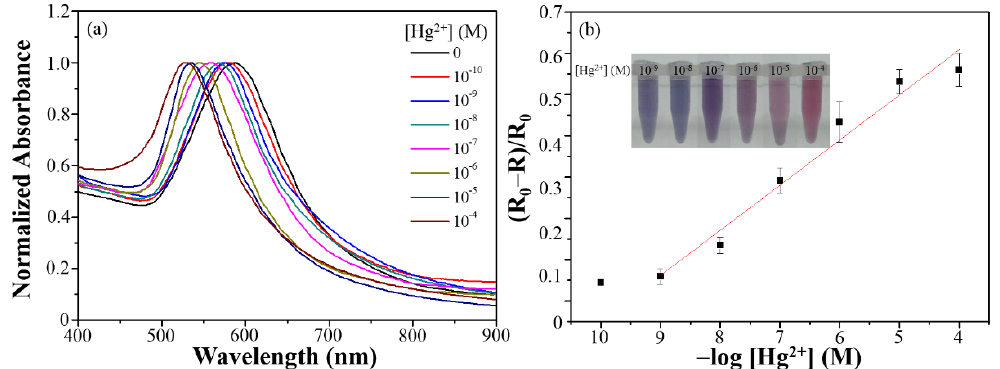
Figure 9. ( a ) UV–Vis absorbance spectra and ( b ) linear responses of the catalytic effect plotted against the Hg(II) concentration. Inset: photographs of the H-AuNS probe in the presence of HCl/Au(III)/H 2 O 2 solution at different Hg(II) concentrations. Error bars represent standard deviations from three repeated experiments.